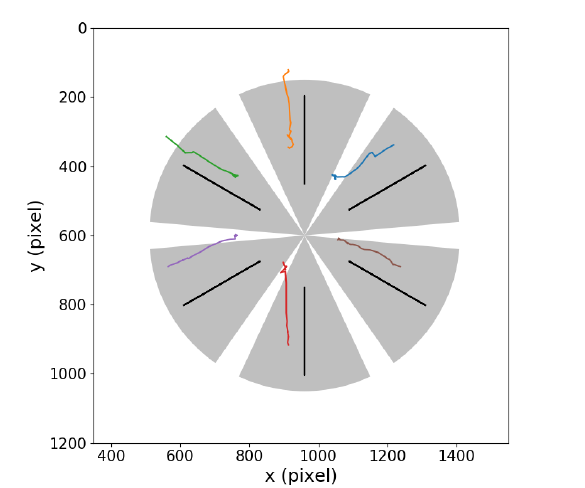
Figure 2: Visualization of the gaze and object